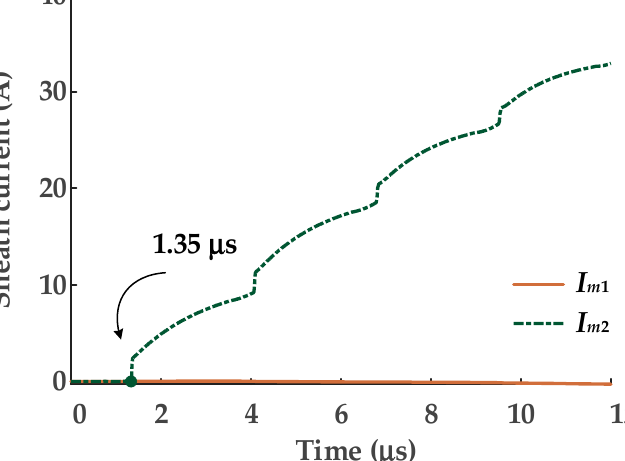
Figure 18. The sheath current waves monitored by the current sensors at the two ends.